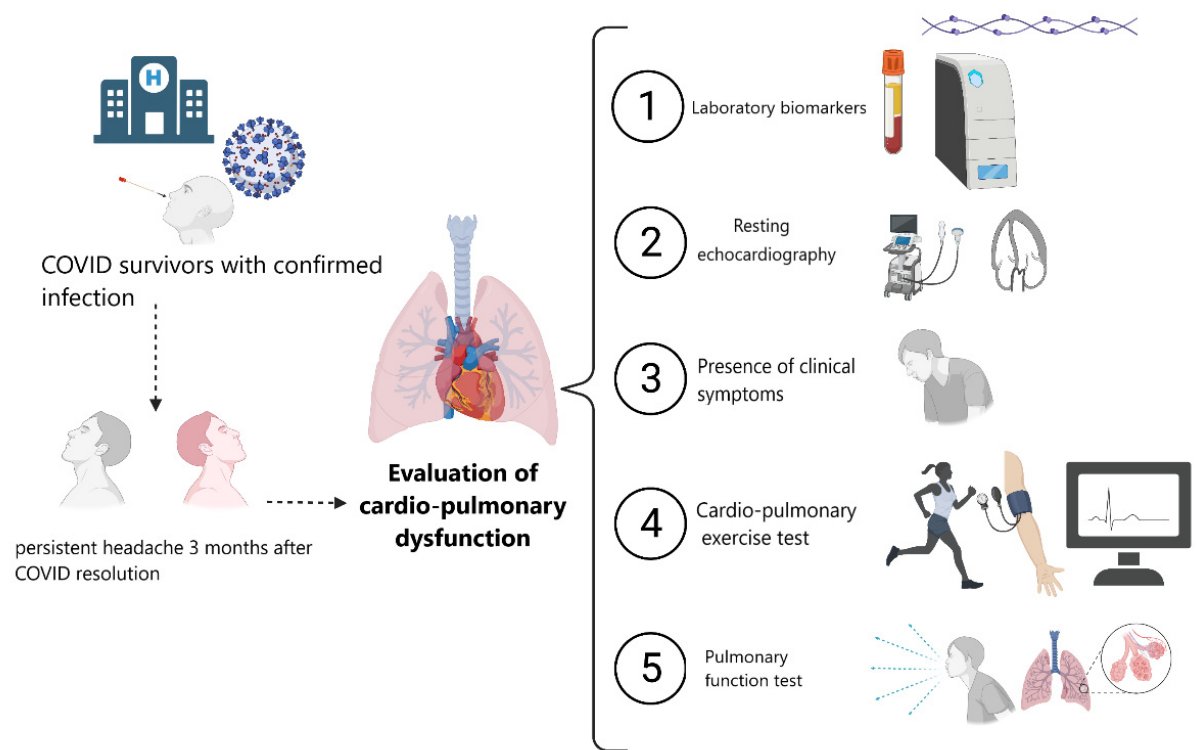
Figure 1. Study Figure 1. Study procedures.